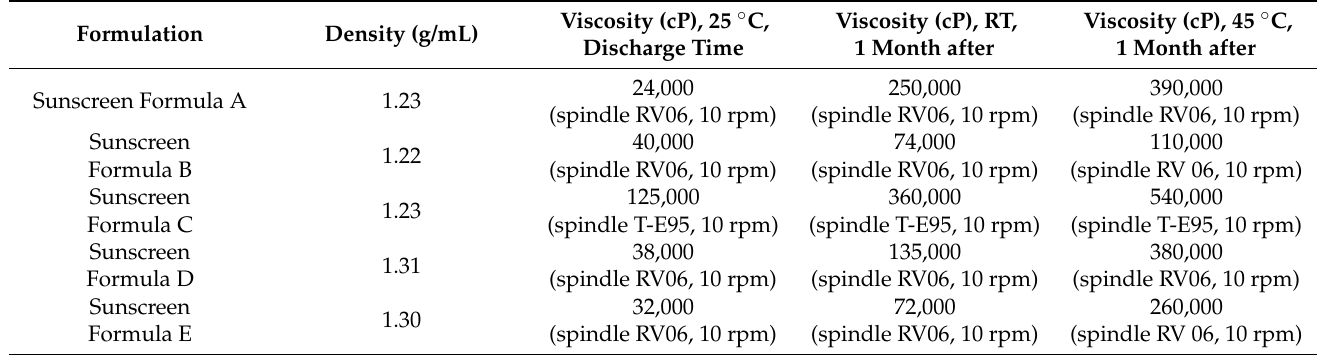
Table 4. Chemical-physical parameters for each formulation.